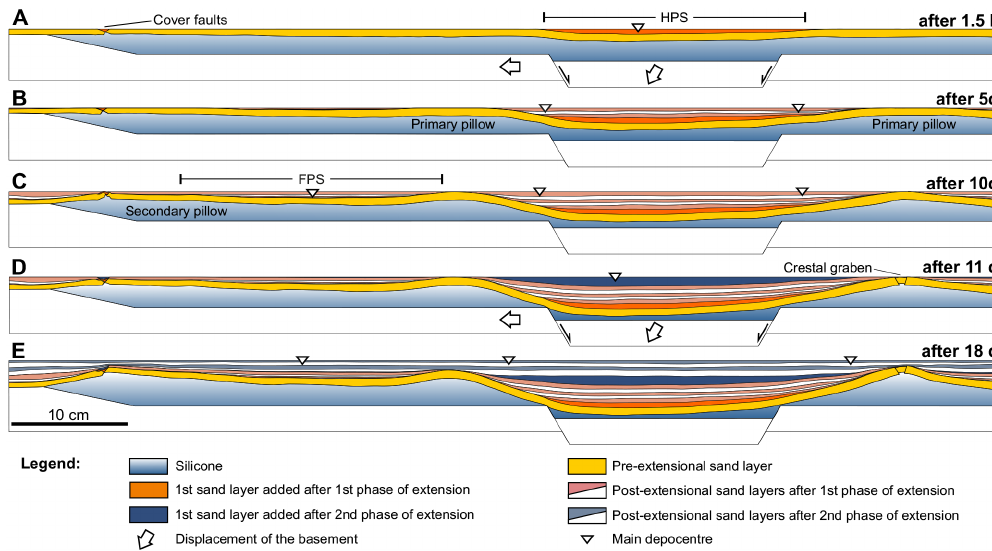
Figure 5. Restoration of final cross-section of Exp. 1b. (a) At the end of basement extension the hanging wall peripheral sink (HPS) begins to subside. (b) Additional sand accumulated causes the formation of pillow structures close to downthrown basement block as well as above the platform at the left side of the box (secondary pillow). (c) The subsidence during the second phase of basement extension is marked by the dark blue layer. (d) Further post-extensional sand accumulation (blue/white) increases the elevation of the pillow-like